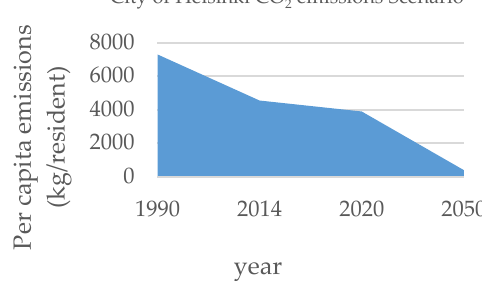
Figure 1. Carbon reduction projection for the city of Helsinki. Note: Figure 1 was created using data accessed from Helsinki Environmental Statistics 2015, Helsinki Region Environmental Services Authority (HSY) and the City of Helsinki Environmental Report from 2014.